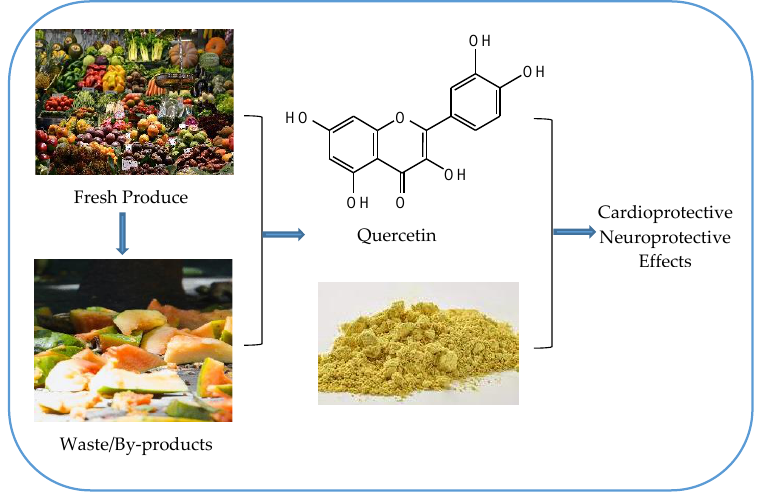
Figure 1. Quercetin: Sources, structure and